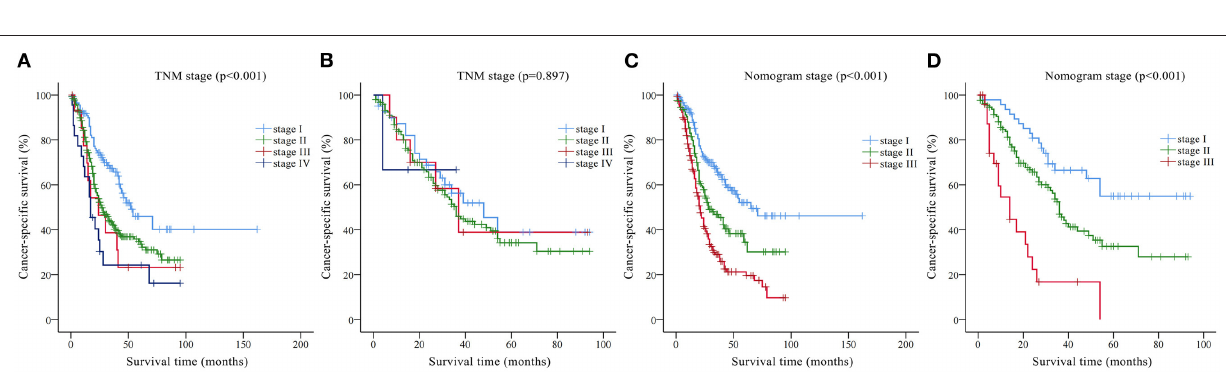
LODDS stage was better than that of the traditional N stage and LNR stage. This conclusion is consistent with that of many previous studies, but the specific staging method for LODDS is still inconclusive. For example, the LODDS stage of medullary thyroid cancer (13) is LODDS1 ( ≤ − 0.9), LODDS2 ( − 0.9 ∼ - 0.1) and LODDS3 ( > -0.1); for gastric cancer (26) is LODDS1 LODDS stages of DCC were LODDS1 ( ≤ -2.00),